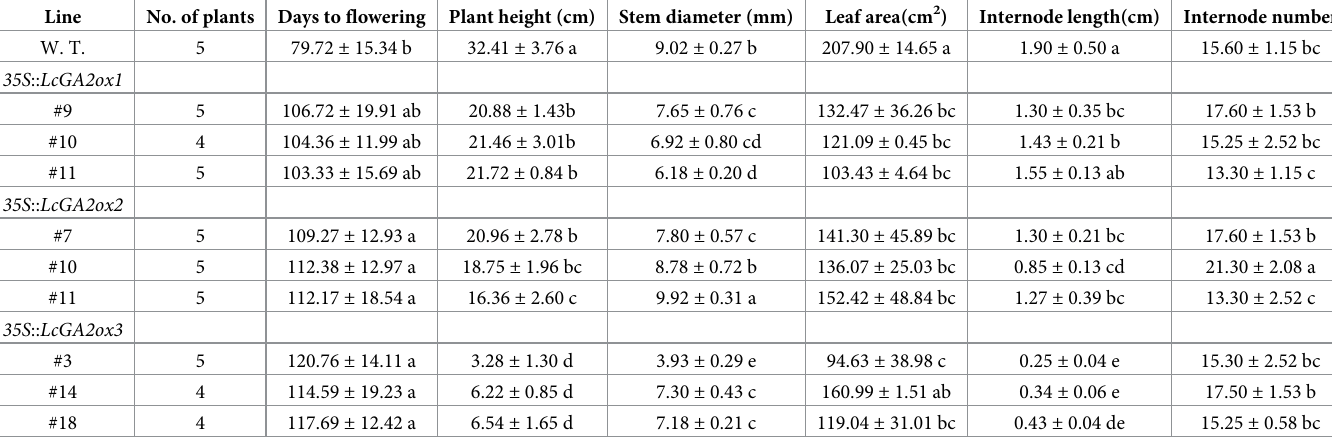
Data were mean ± SE of three biological replicates. Different lowercase letters indicate significant difference at the 0.05 level among 8 sampling sites based on Duncan multiple range